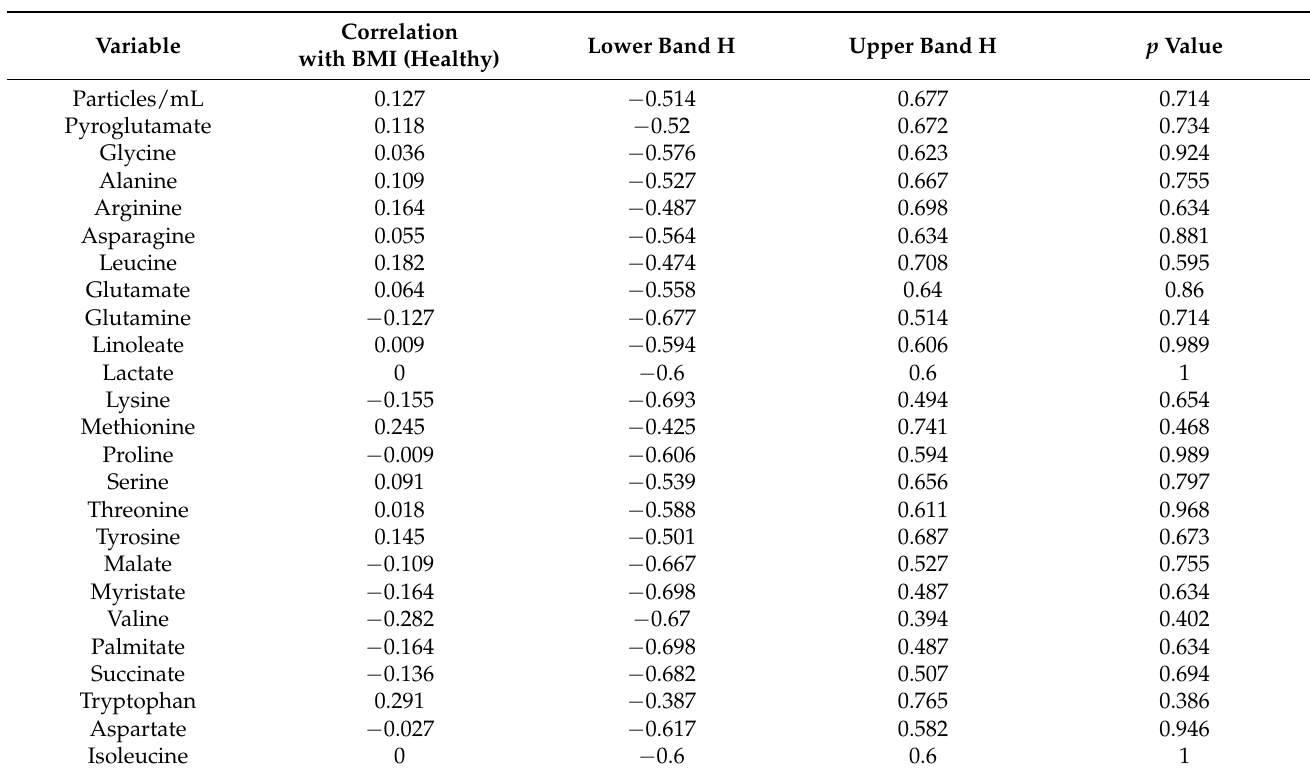
Table 6. Spearman’s rank correlation between BMI and the metabolite levels in the EVs isolated from healthy control participants.